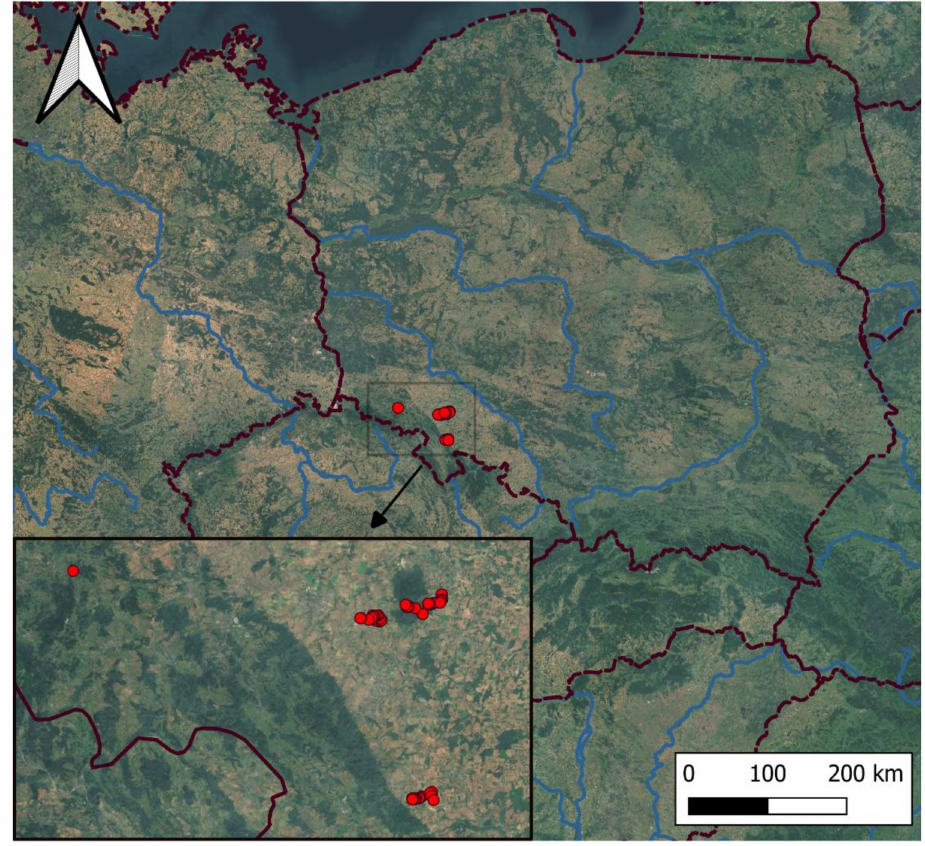
Figure 1. Area of investigation. Dots indicate the location of the relev é s from serpentine forests in SW Poland analyzed in this study (©MapTiler ©OpenStreetMap